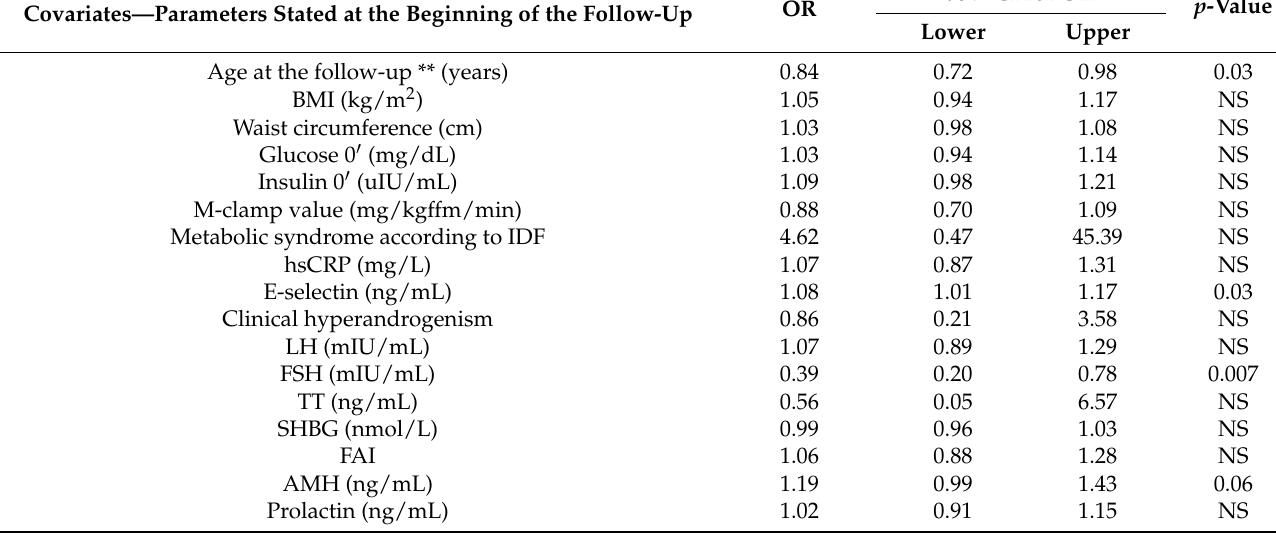
Table 6. Predictors of PCOS *